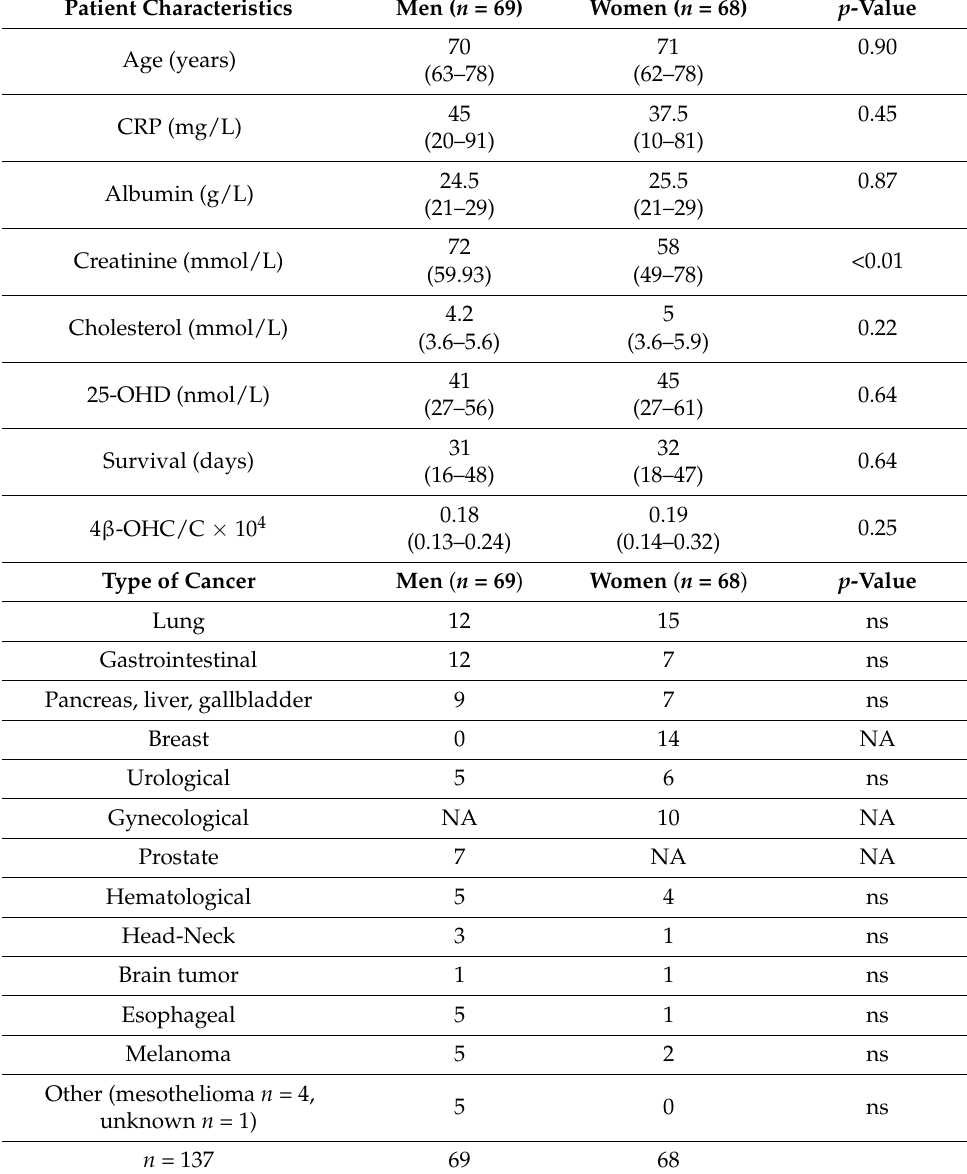
Table 1. Demographic data of the 137 cancer patients in the study cohort which were included 1–60 days before death. Median values and interquartile range (IQR) are presented. Statistical analysis was performed with Mann–Whitney test for continuous variables and Fischer’s exact test for binary